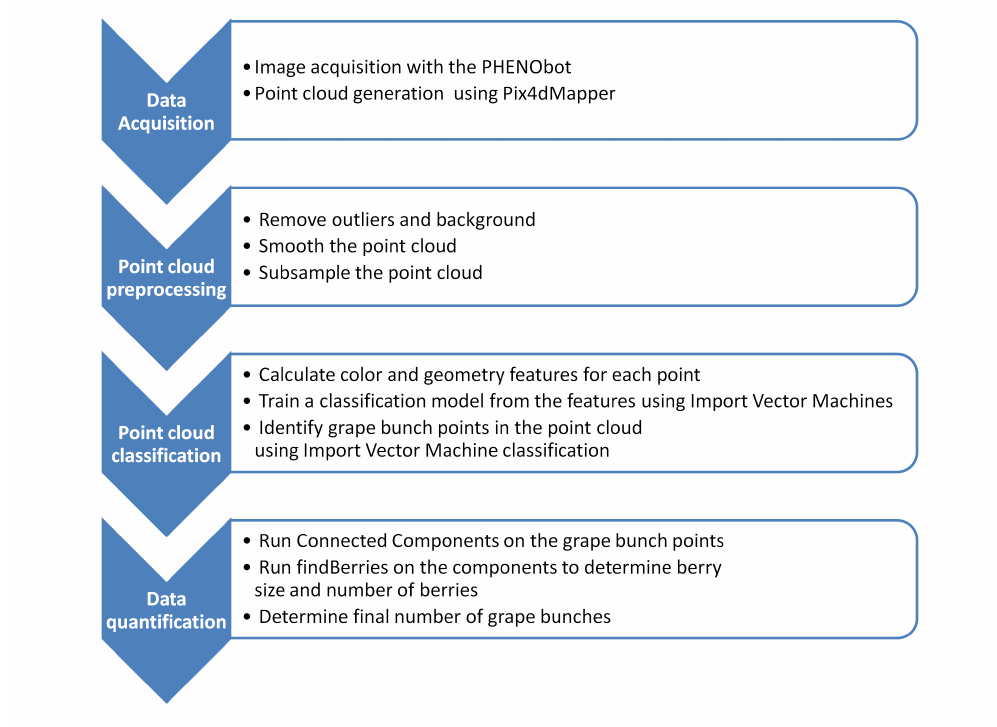
Figure 1. The workflow of the